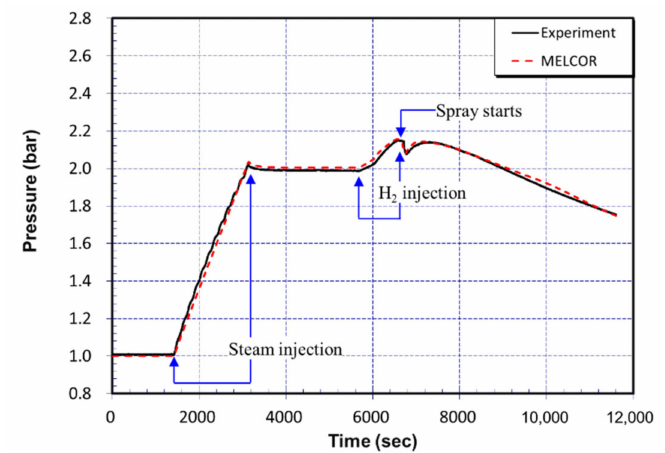
Figure 10. Comparison of gas pressure inside the test vessel between SSP1 test data and MELCOR prediction.